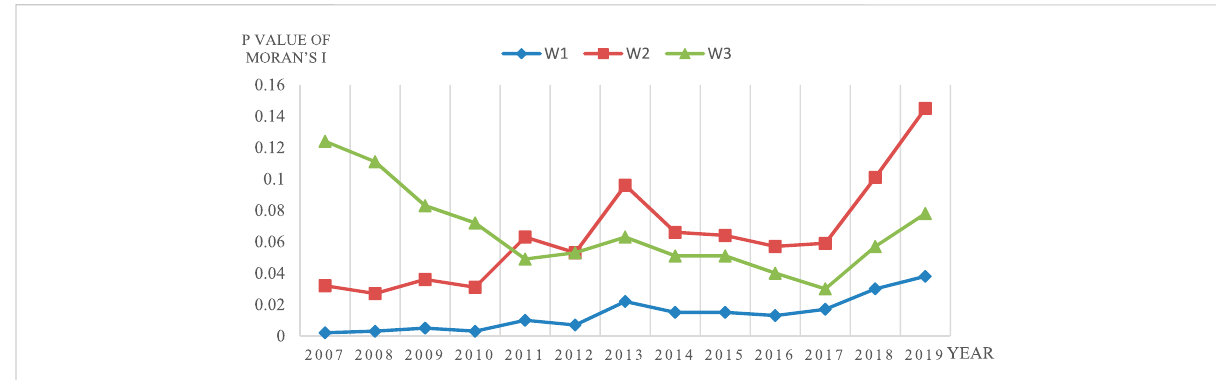
FIGURE 3 Moran ’ s I of carbon productivity in China under three spatial weight matrices from 2007 to 2019.